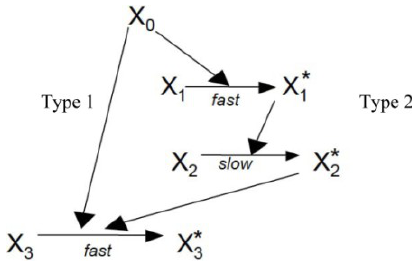
Figure 9. The effect of concentration ( X ) variation of the molecule that opens the type 1-type 0 2 loop network. Two different values of X were studied: 1 (left panel) and 20 (right panel). 0 Results are shown to be robust for a 2-fold variation in concentration fluctuations for other molecules: normal concentration ( a and d ), 2-fold underexpression ( b and e ), 2-fold overexpression ( c and f ). The minimal network was analyzed using the stochastic differential equations developed in [2]. The SDE that captures low probability reaction of X  X * 2 2 (slow step) was solved using a Poisson Runge-Kutta scheme [12]. In this method, the number of times a specific reaction channel fires in a given time t is a Poisson random variable with mean  t and variance  t , where  is the propensity function. For the slow reaction under consideration  = k(δt)X * X . The rate constant for the slow step is k and δt is the time-step 1 2 used in the numerical solution. All other reaction SDEs were solved using the standard Euler-Maruyama numerical scheme for solving stochastic differential equations